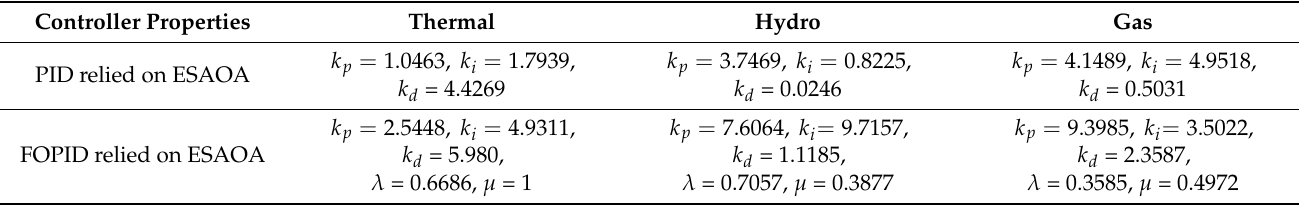
Table 9. The optimal controllers’ values for scenario C.